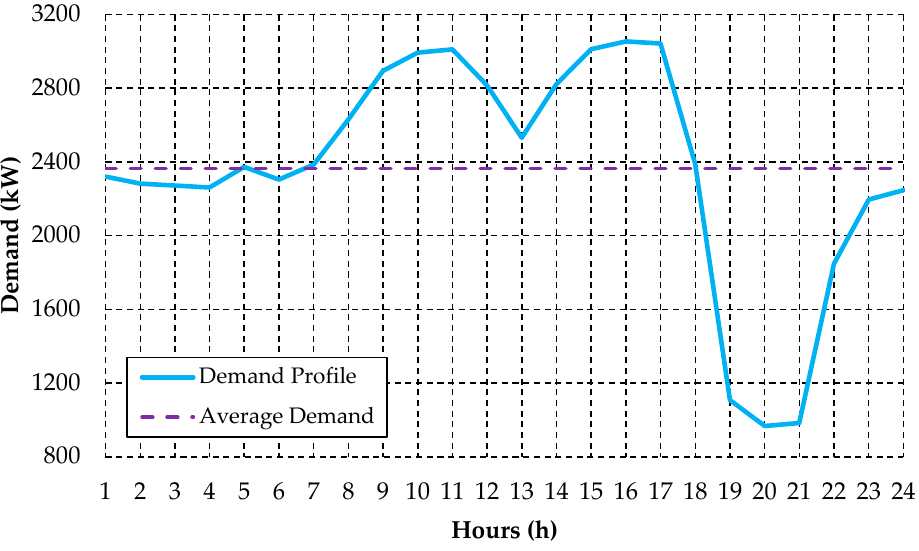
Figure 18. Daily demand profile of the irrigator customer group present at the Rural Feeder B. Source: The authors.